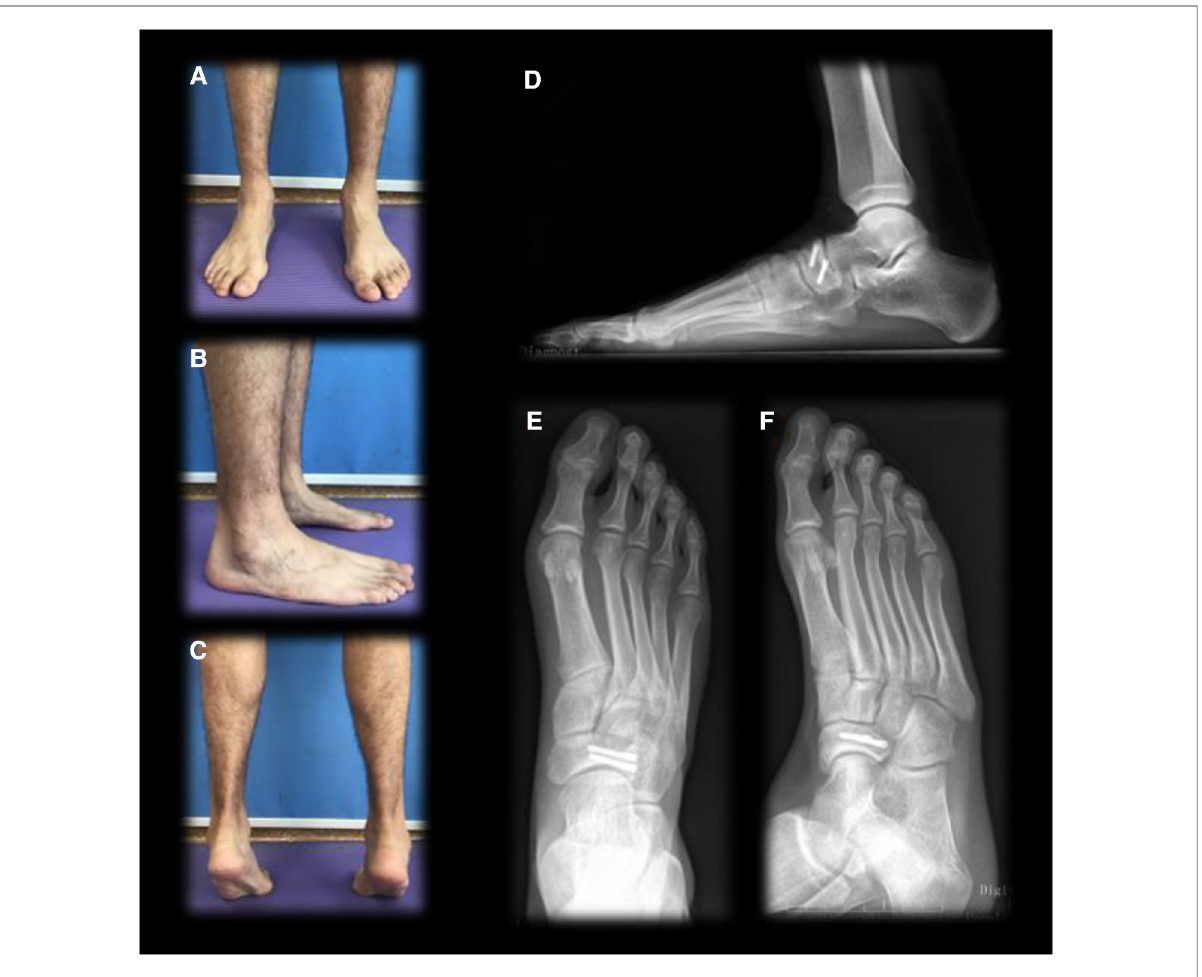
FIGURE 7 One year postoperative follow-up. ( A ) Front view standing on two feet; ( B ) lateral view of the affected foot standing on two feet; ( C ) rear view with both feet on tiptoe; ( D ) weight-bearing lateral x-ray of the right foot; ( E ) anteroposternal x-ray of the right foot; ( F ) oblique x-ray of the right